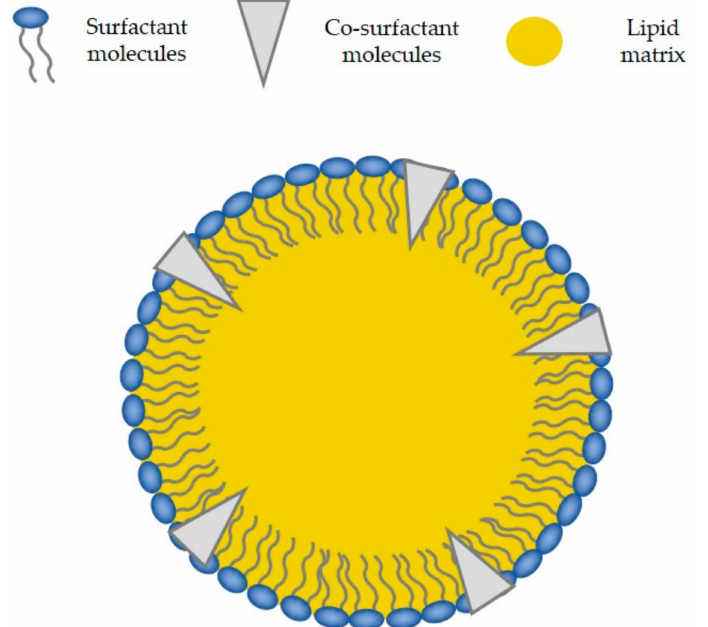
Figure 2. Scheme of the proposed structure of a solid lipid nanoparticle showing the solid lipid matrix, the surfactant, and the